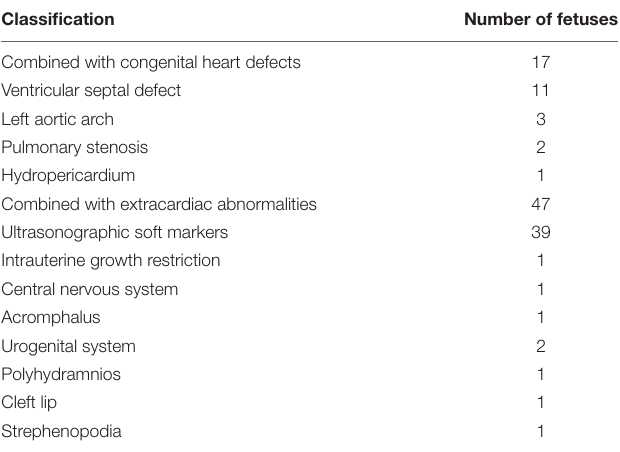
TABLE 1 | Fetuses (64 cases) with non-isolated